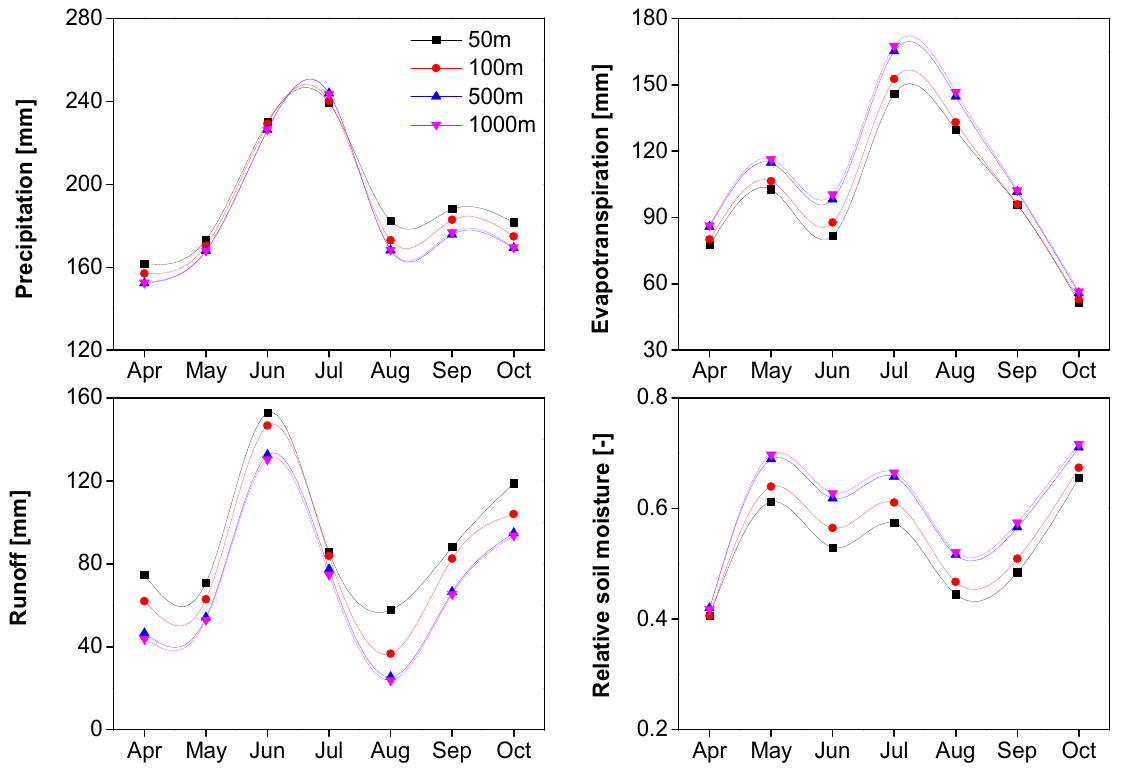
Figure 5. The monthly precipitation, evapotranspiration, runoff and relative soil moisture